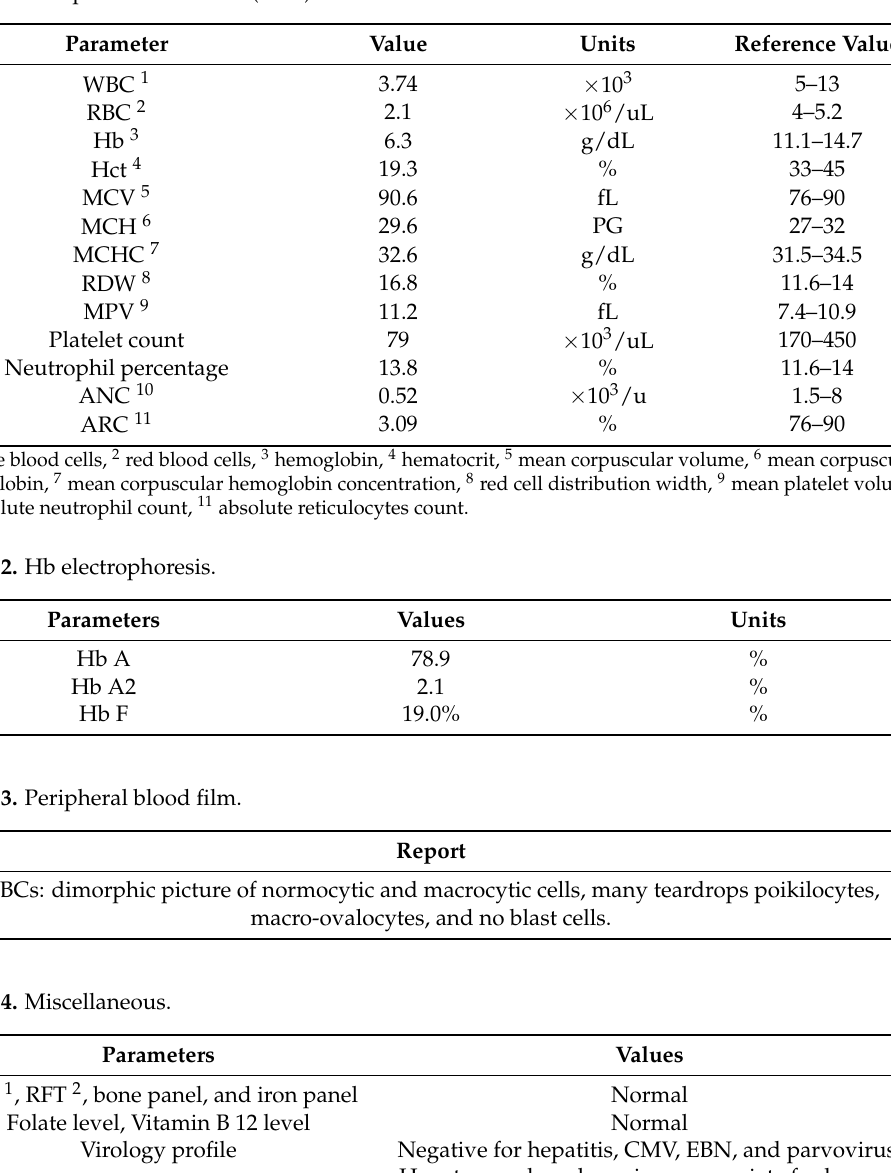
Table 1. Complete blood count (CBC).